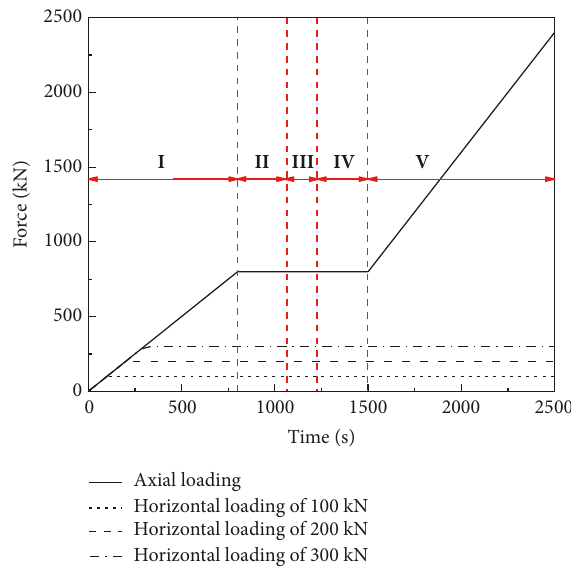
Figure 3: Loading process (I: initial loading; II: maintaining the loading number in two directions; III: detaching the filling body; IV: maintaining the loading number in two directions; V: loading in the vertical direction